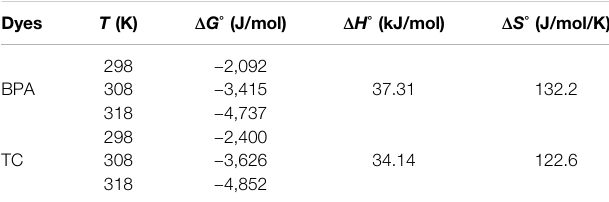
TABLE 5 | Thermodynamic parameters for BPA and TC adsorption on Fe 3 O 4 @